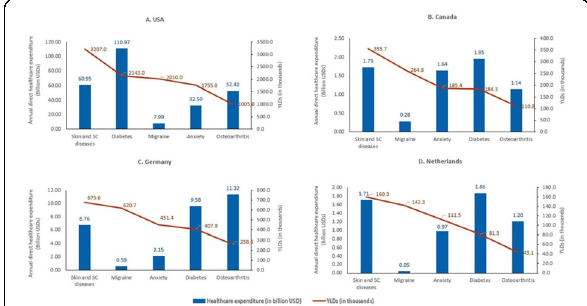
Fig. 1 (abstract P84). Annual direct healthcare expenditure for causes with high disability in the USA, Canada, Germany, and the Netherlands (Comparisons were made for 10 causes of high disability in each country. Data for the top five high disability diseases that were common across all four countries are presented). Abbreviations: Anxiety: Anxiety disorders; Diabetes: Diabetes